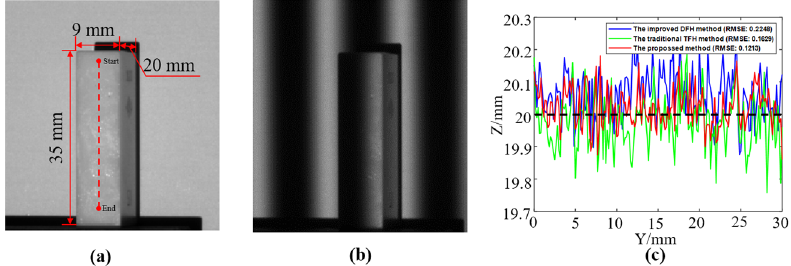
Figure 14. Measurement on a ceramic standard gauge block. ( a ) Dimension of the gauge block (the red dotted line refers to the area where the three methods are compared). ( b ) One of the captured deformed fringe patterns. ( c ) Comparison of the results obtained by the three methods along the red dotted line (the RMSE of each method is marked).